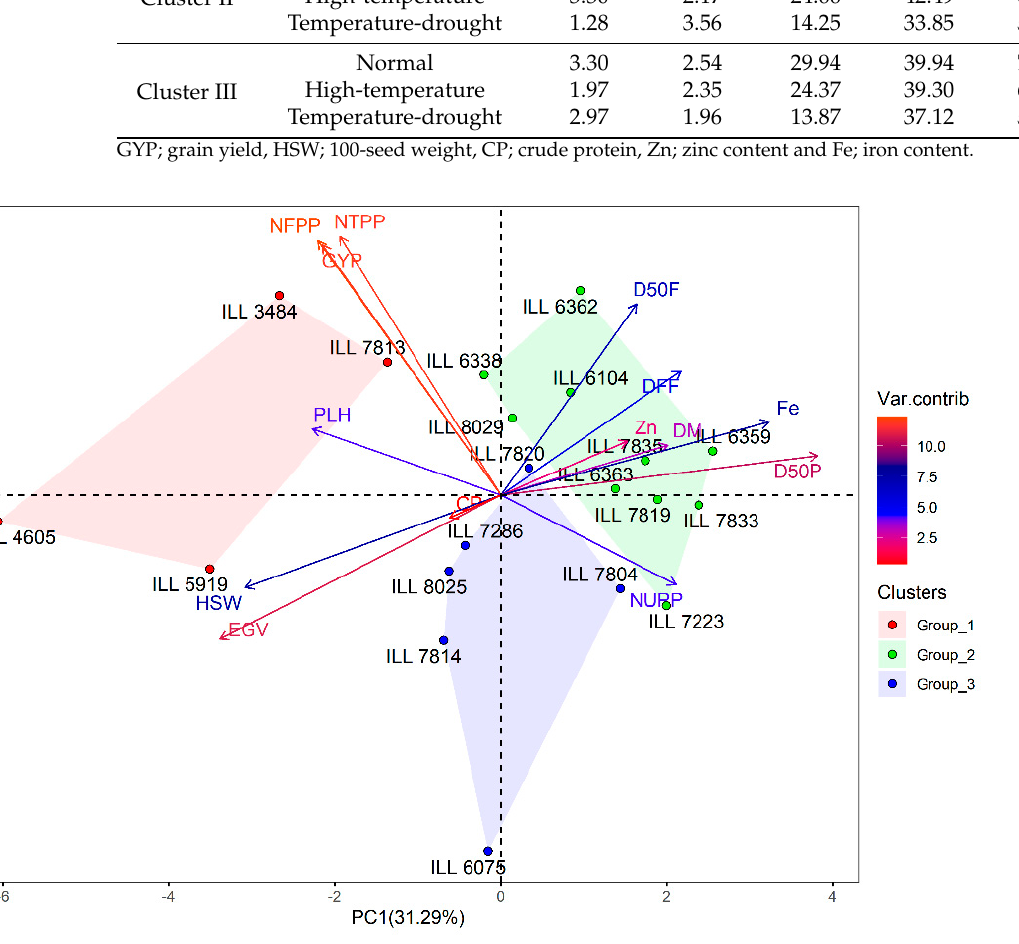
Figure 2. Biplot of the first two axes of the PCA analysis summarizing the relationship between the measured variables and the classification of lentil genotypes under normal conditions.